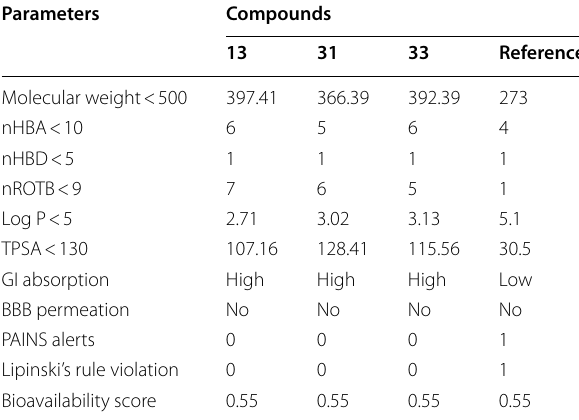
Table 8 Predicted physicochemical parameters of MAO-B inhibitor and referenced drug Parameters